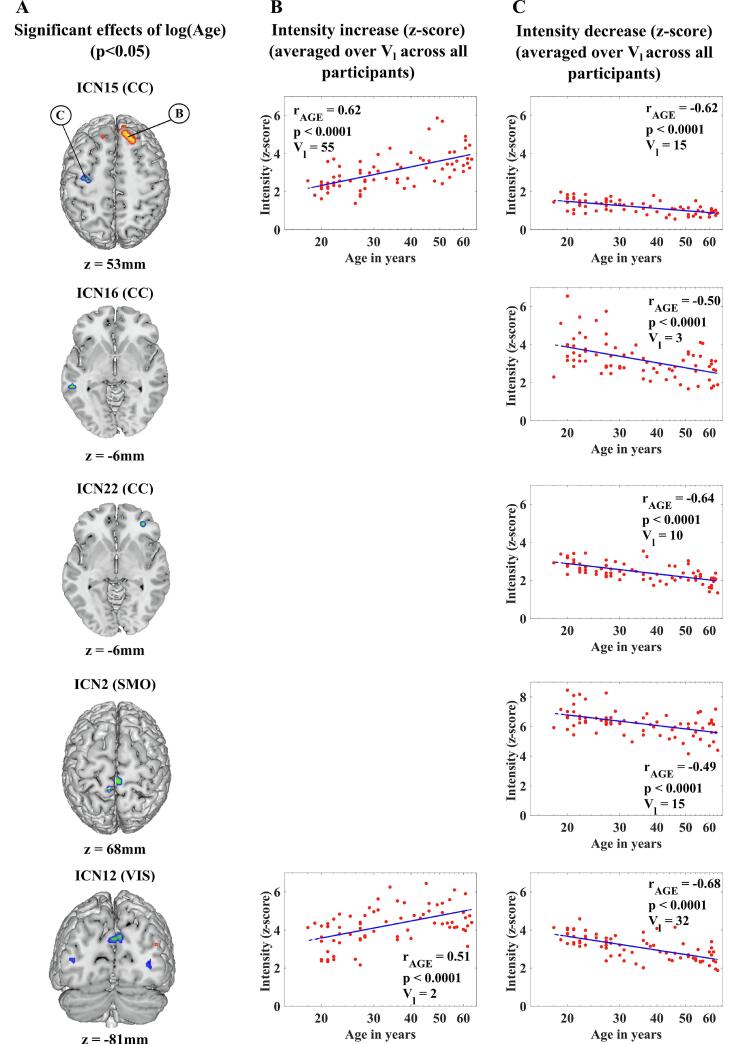
Effects of age on SM intensities. (A): Significant effects of age for each ICN SM (p < 0.05, FDR-corrected) in a representative slice. The top panel indicates an example of a cluster with significant SM intensity increase for increasing age (B in the circle) and an example of cluster with significant SM intensity decrease for increasing age (C in the circle). (B;C): Scatterplots depicting how SM intensities change for increasing age. Age is presented in the scatterplots on a log-scale.